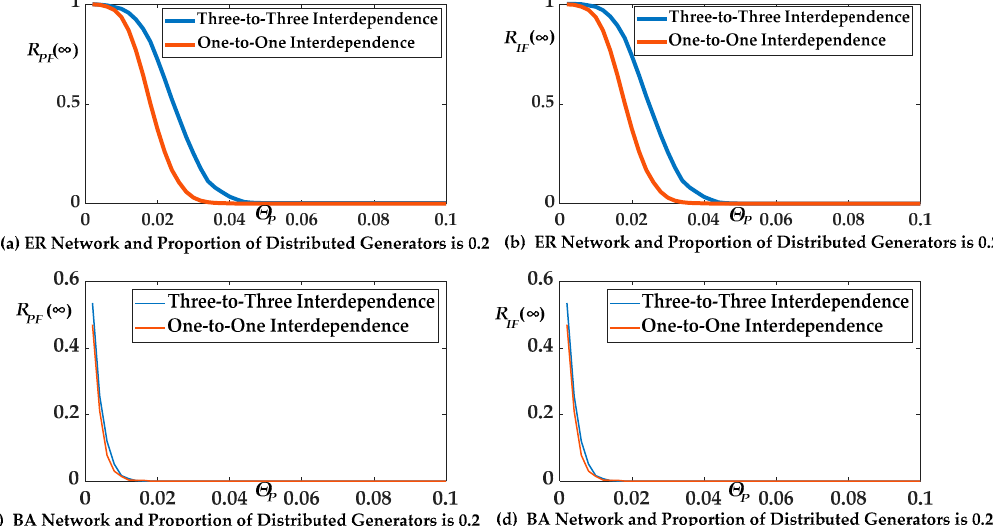
∞ ) / R ∞ ) of di ff erent independence between the PN and IF ( Figure 8. R PF ( ∞ )/ R IF ( ∞ ) of different independence between the PN and CN. Figure 8. R PF (